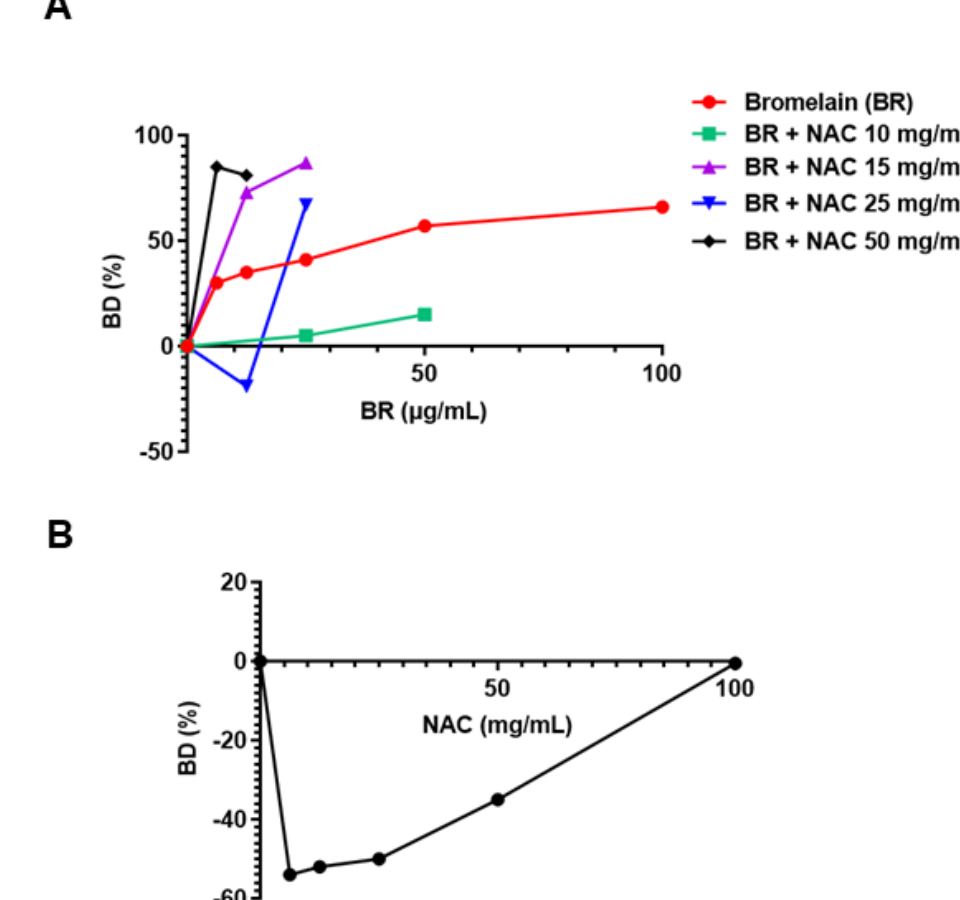
Figure 1. ( A ) Dissolution of biofilm formed by Pseudomonas aeruginosa ATCC 27853 by bromelain and N -acetylcysteine. The graph shows biofilm dissolution (BD) > 80% of biofilm when bromelain was combined with 15, 25, or 50 mg/mL N -acetylcysteine (NAC). Bromelain at 100 µ g/mL only gave a BD of 66%; however, in suitable combinations, the BD was above 80%, indicating very good efficacy. Further, NAC 10 mg/mL + bromelain 25 or 50 µg/mL gave very low BD values. ( B ) Dissolution effect of N-acetylcysteine on biofilm secreted by Pseudomonas aeruginosa ATCC 27853. The graph indicates negative dissolution activity (biofilm growth) with all additions of NAC, which returns to 0% BD at NAC 100 mg/mL.